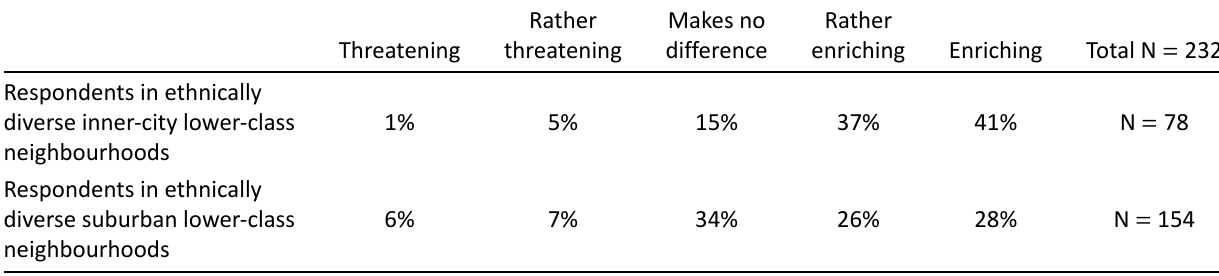
Table 1. People of Dutch descent (18 to 35 years of age) in ethnically diverse Amsterdam neighbourhoods. Survey ques- tion: “Do you think that living together with people of different ethnic origin is an enrichment or a threat to your own way of living?”